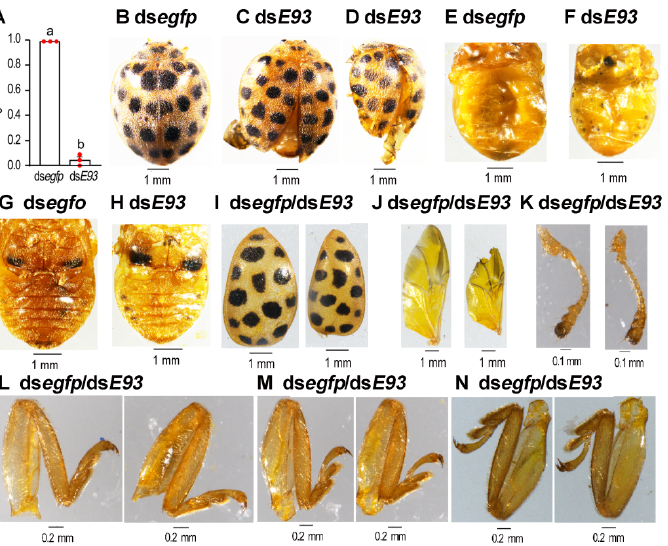
Figure 5. RNAi of both HvE93 isoforms in the final instar larvae affects adult emergence in Henosepilachna vigintioctopunctata larvae. The emergence rates of the treated and control lady- birds were recorded during a 3-week trial period ( A ). Statistical significances ( p value < 0.05, showing by different letters above the columns) between treatment and control (means ± SE) were calculated using an independent sample t -test. The defective phenotypes of the treated adults ( C , D ) are shown, compared with the control ( B ). The sizes of the abdomen ( F , H vs. E , G ), the elytrum ( I ), the hindwing ( J ), the antennae ( K ), the foreleg ( L ), the midleg ( M ) and the hindleg ( N ) of the treated adults were compared with the corresponding organs from controls (right vs. left